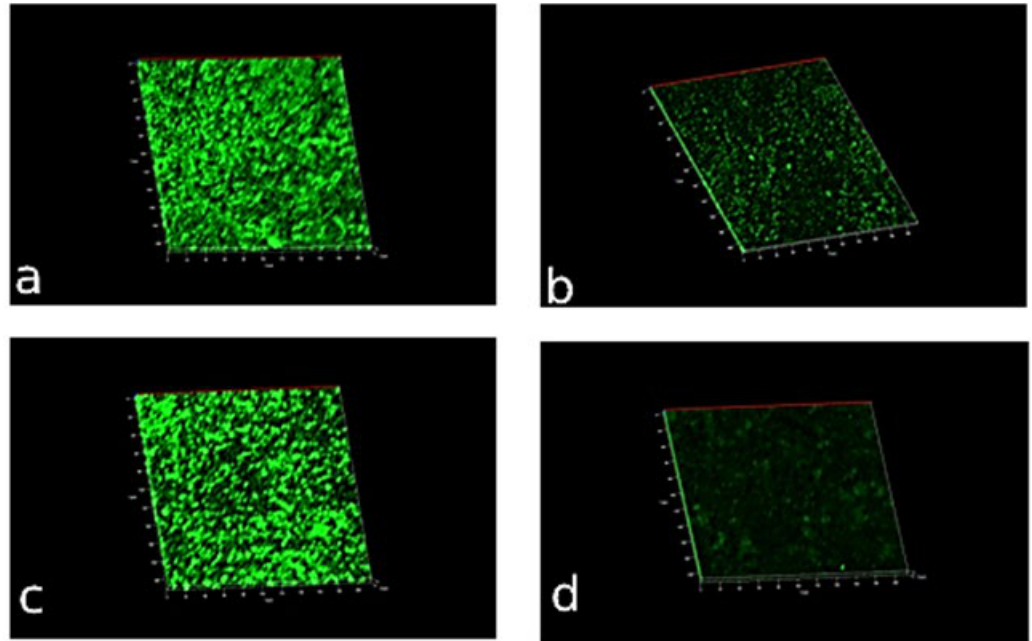
Fig. 8B. Confocal microscopic observation of inhibitory effects of Chitosan/Hydroxyapatite nanocomposite on biofilm